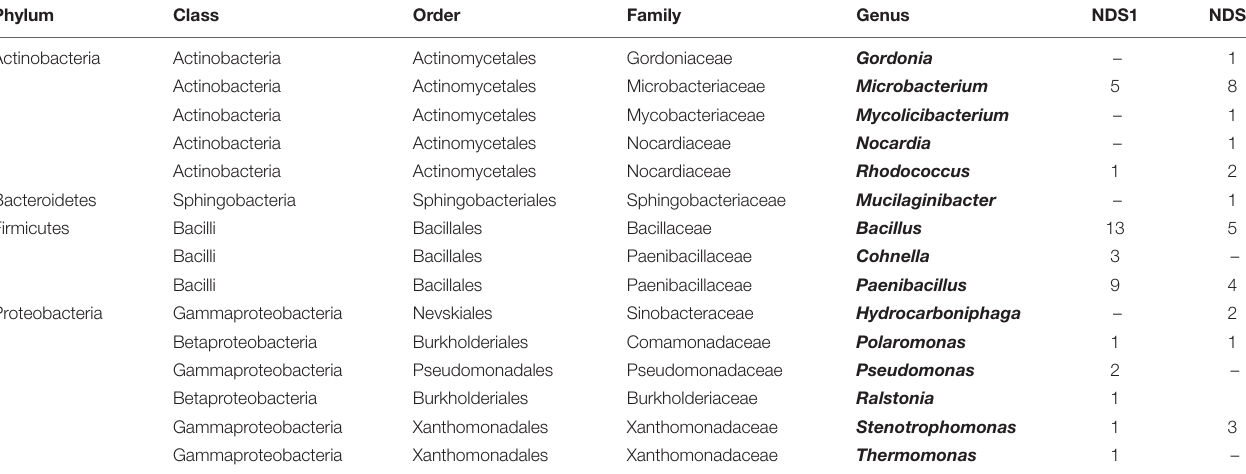
TABLE 3 | Bacterial genera isolated from the NDS tanks.